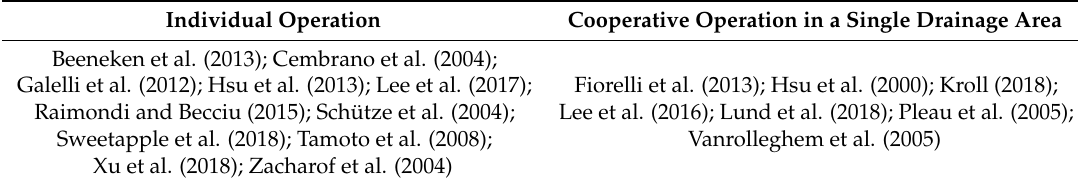
Table 1. Classification of real-time control (RTC) in urban drainage